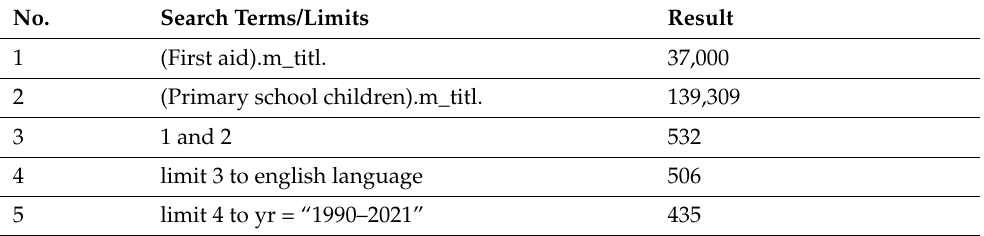
Table A1. PubMed search 3 January 2022.